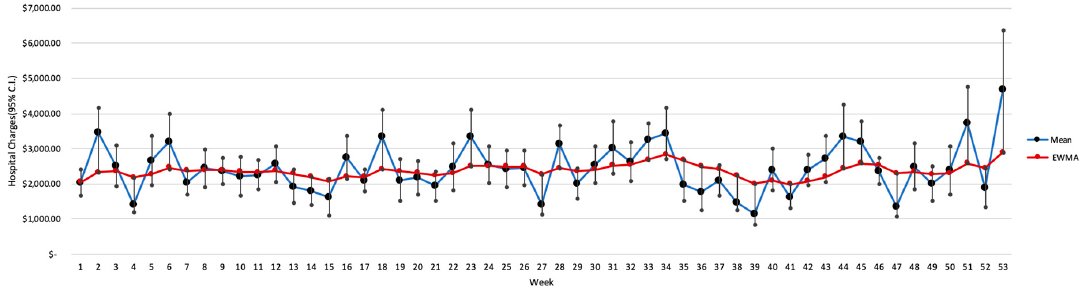
Figure 5. Hospital charges difference of means and 95% CI between correct and incorrect Dx of pneumonia.